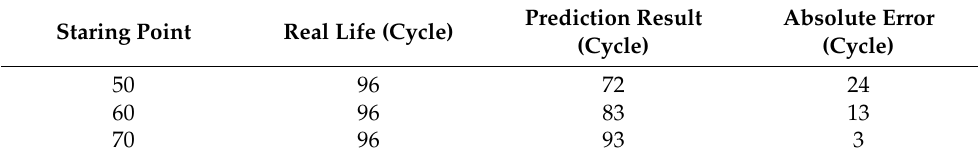
Table 3. Prediction error